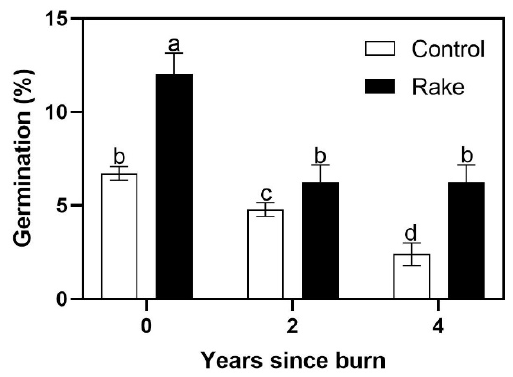
Figure 4. Percentage of Eucalyptus benthamii seed germination after zero, two, and four years after prescribed fire with and without rake in the field. Error bars indicate the standard error. Means sharing a letter are not significantly different (Tukey’s HSD, α = 0.05).